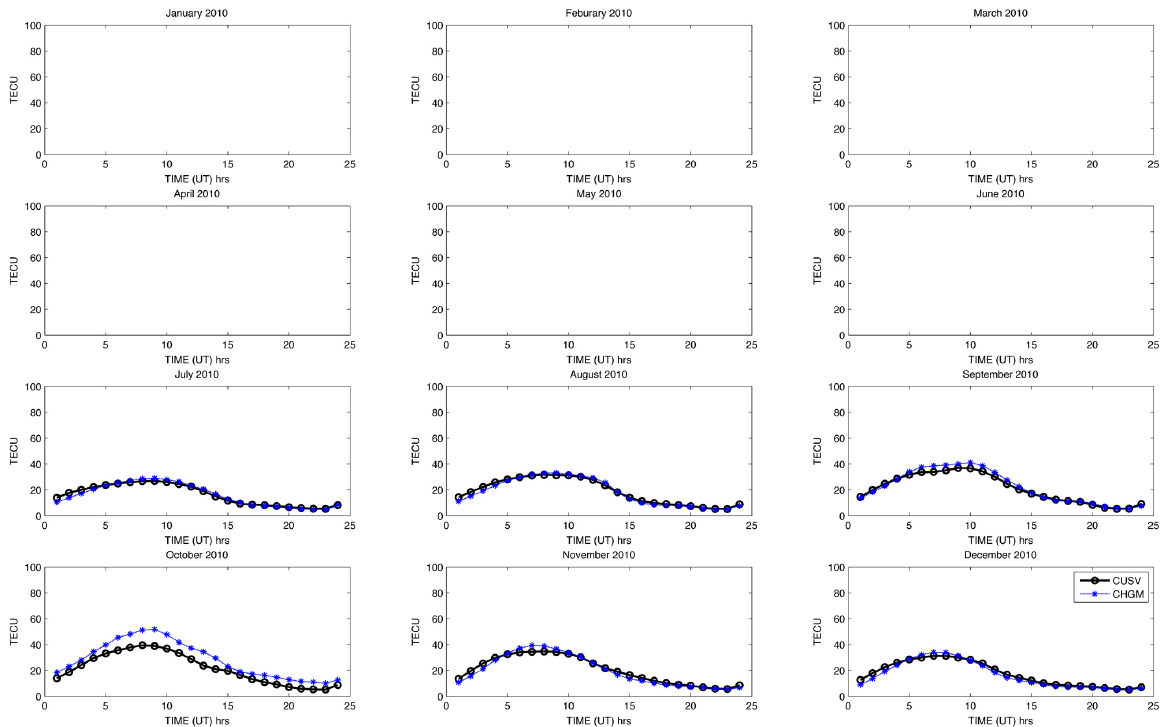
Figure 9. Comparison of monthly variations of mean GPS TEC values at CHGM and CUSV stations during the period